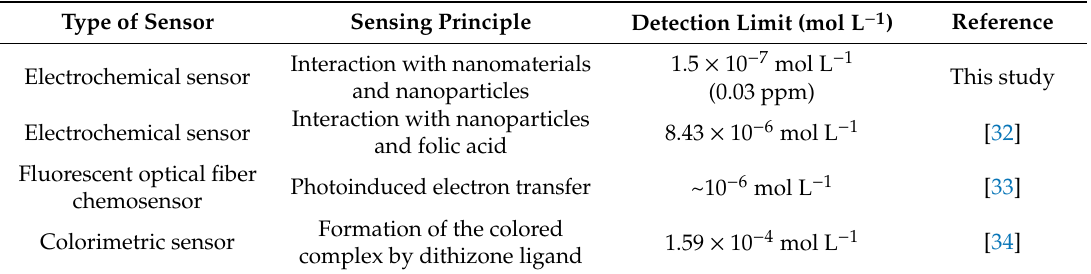
Figure 11. Calibration curve between the current peak of differential pulse voltammetry (DPV) and the potential. Table 2. Comparison with other sensor methods for determination of mercury.